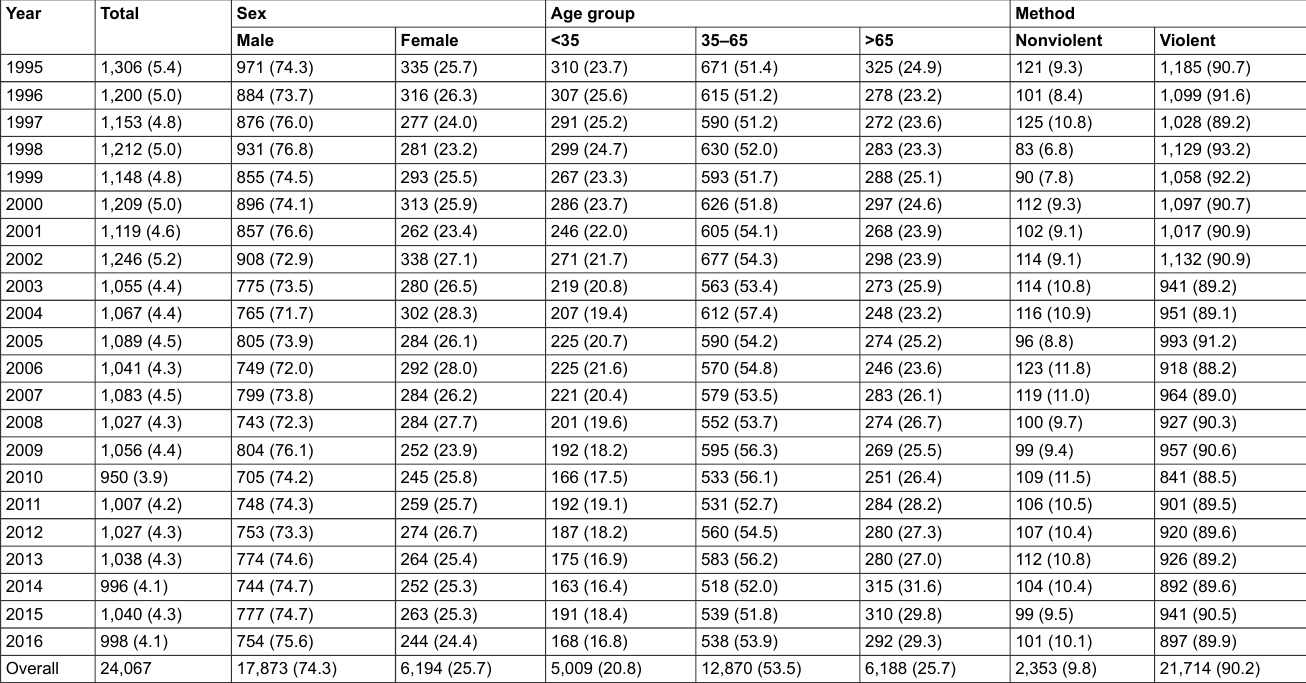
Table S4: Summary statistics of suicides per year in Switzerland.